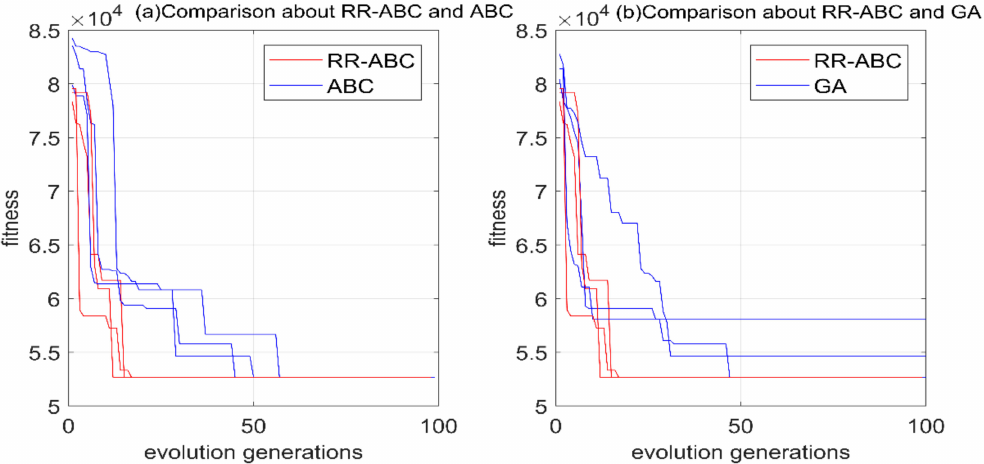
Figure 14. Comparison of evolutionary performance: ( a ) Comparison about RR-ABC and ABC; ( b ) Comparison about RR-ABC and GA.